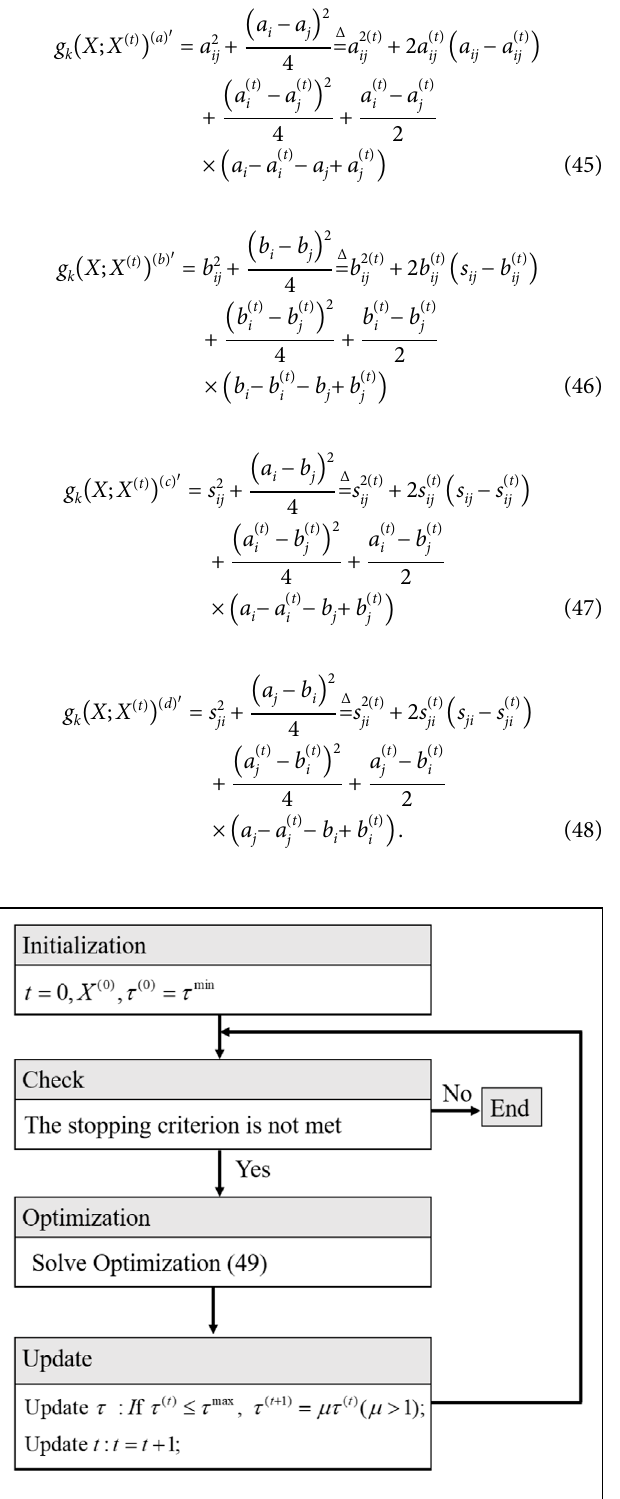
FIGURE 2 | Solving process of the proposed